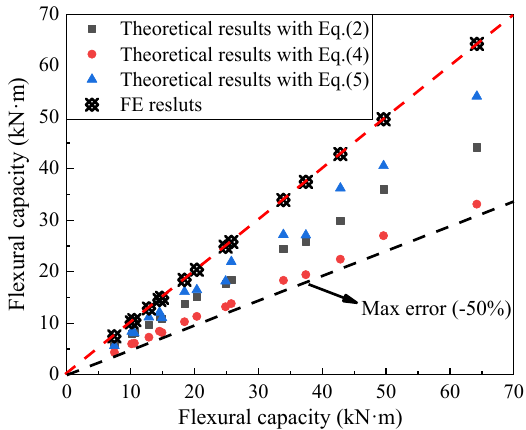
Figure 21. Comparison of different correlations for the flexural capacities of AACPs. As specified in the Chinese code for the design of concrete structures [18], the cracking moment of concrete M cr can be estimated using Equation (6)